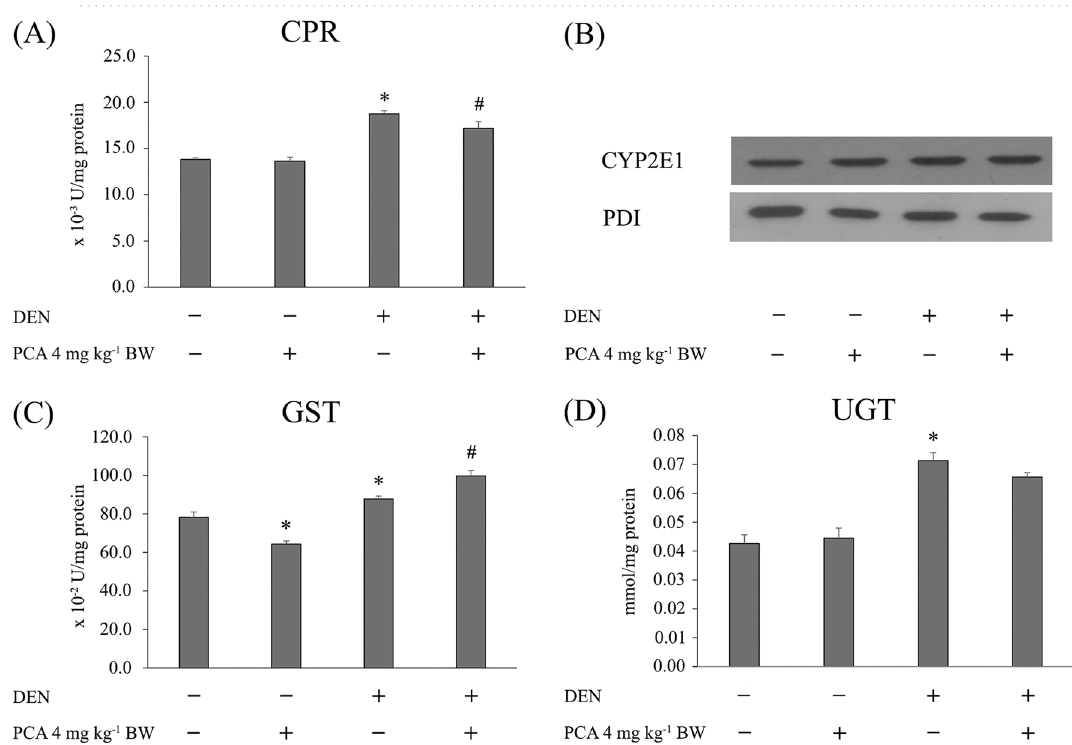
Figure 3. Effect of purple rice bran extract and protocatechuic acid on some phase I and phase II xenobiotic- metabolizing enzymes (5-week protocol). ( A ) CPR: NADPH: cytochrome P450 reductase activity; ( B ) Western blotting of cytochrome P450 2E1 (CYP2E1); ( C ) GST: glutathione- S -transferase activity; ( D ) UGT: UDP- glucuronyltransferase. Values are expressed as mean ± SEM. *Significantly different from the negative control group, p < 0.05. # Significantly different from the positive control group, p < 0.05. DEN: diethylnitrosamine, PCA: protocatechuic acid, PRBE: purple rice bran